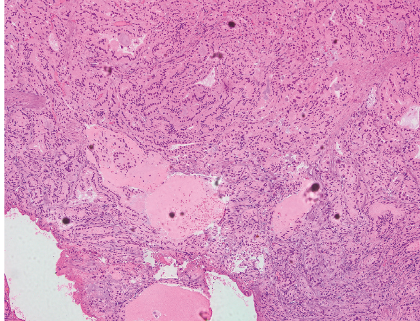
Figure 3: Histopathology showing thyroid follicles filled with